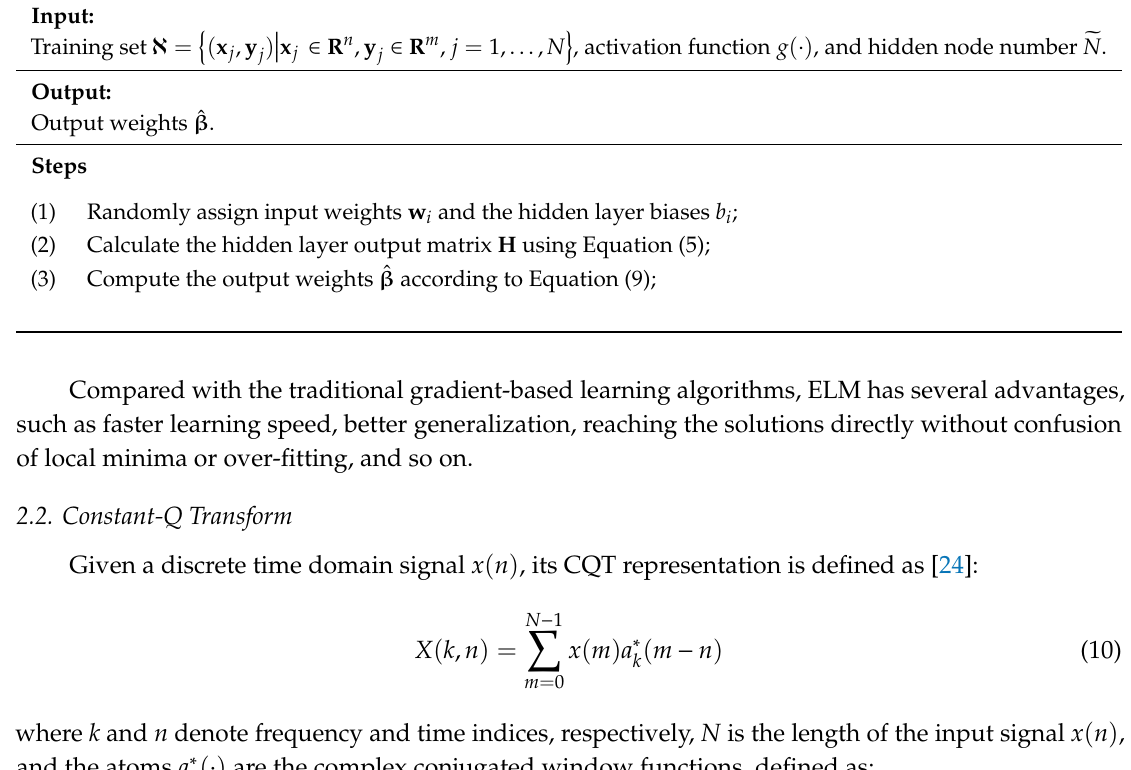
Algorithm 1. Procedure of ELM